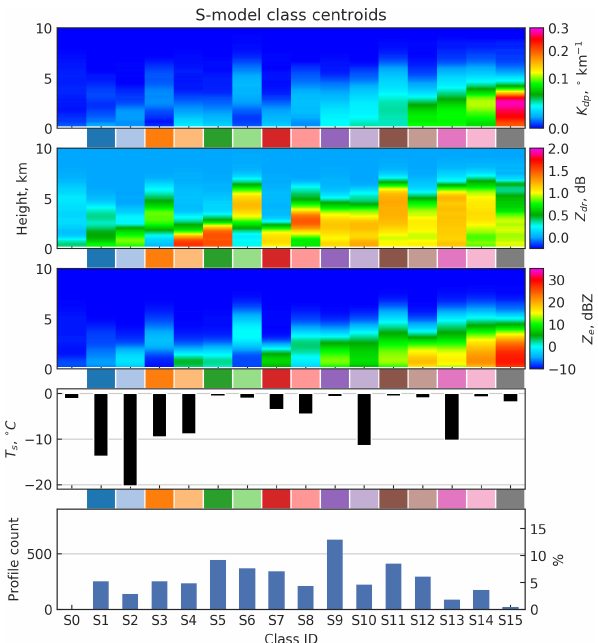
Figure 3. Class centroid profiles of the S model. The top panel shows class centroid surface temperatures. Profile counts per class are shown at the bottom omitting the count for low-reflectivity class S0. Between the panes, each class has been assigned a color